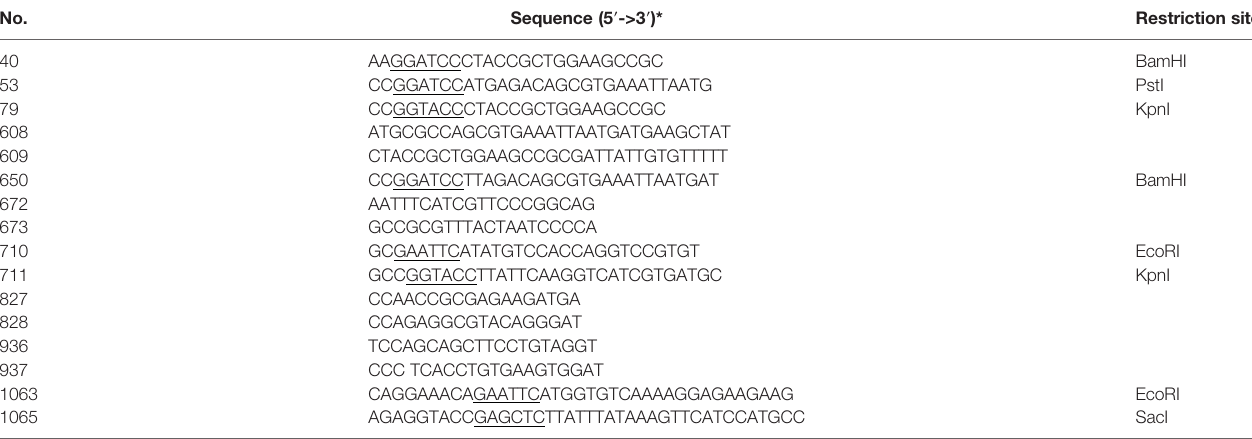
TABLE 1 | Primers used in this study.